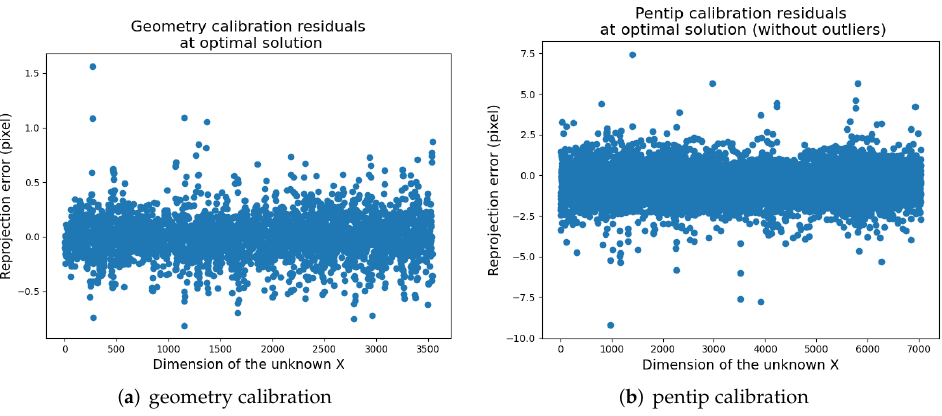
Figure 12. residual plots for each stage of calibration.